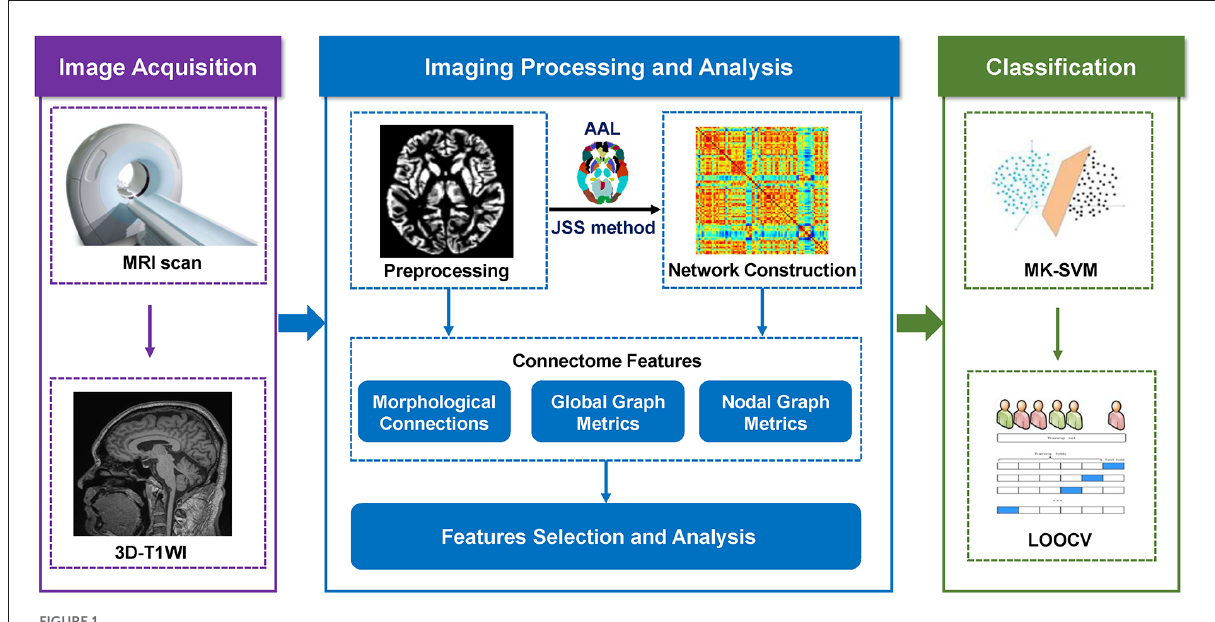
FIGURE1 The procedure of data processing and